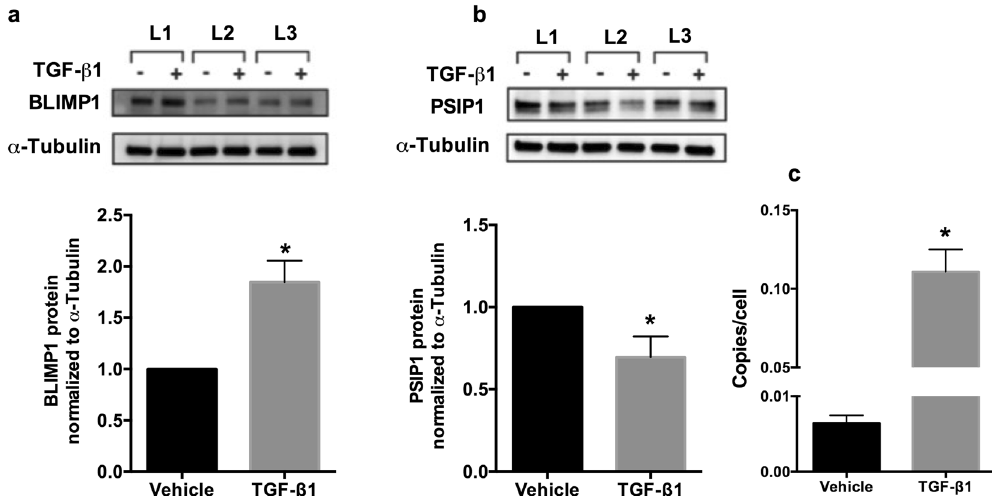
Figure 3. TGF- β 1 alters the protein expression of HIV-1 restriction factors such as BLIMP-1 and PSIP-1 in NHBE cells. NHBE ALI cultures were treated with recombinant TGF- β 1 (or vehicle as control). 48 hours post- treatment, total protein was isolated and quantified by western blot analysis. ( a ) BLIMP-1 protein levels were significantly higher in TGF- β 1 treated NHBE ALI cultures compared to vehicle treated controls. ( b ) TGF- β 1 suppresses PSIP-1 protein levels in NHBE ALI cultures compared to vehicle treated controls. ( c) TGF- β 1 treatment demonstrates increased HIV integration events in NHBE cells. NHBE ALI cultures were treated with recombinant TGF- β 1 (or vehicle as control). 16 hours post-treatment NHBE ALI cultures were infected with 5 ng p24 equivalent of HIV BaL (R5-tropic strain) and the infection was allowed to proceed for an additional 24 hours. Experiments were terminated and genomic DNA was isolated and used to quantitate integrated HIV proviral DNA. n = NHBE ALI cultures from 3 different lungs; * significant (p < 0.05). L = Lung